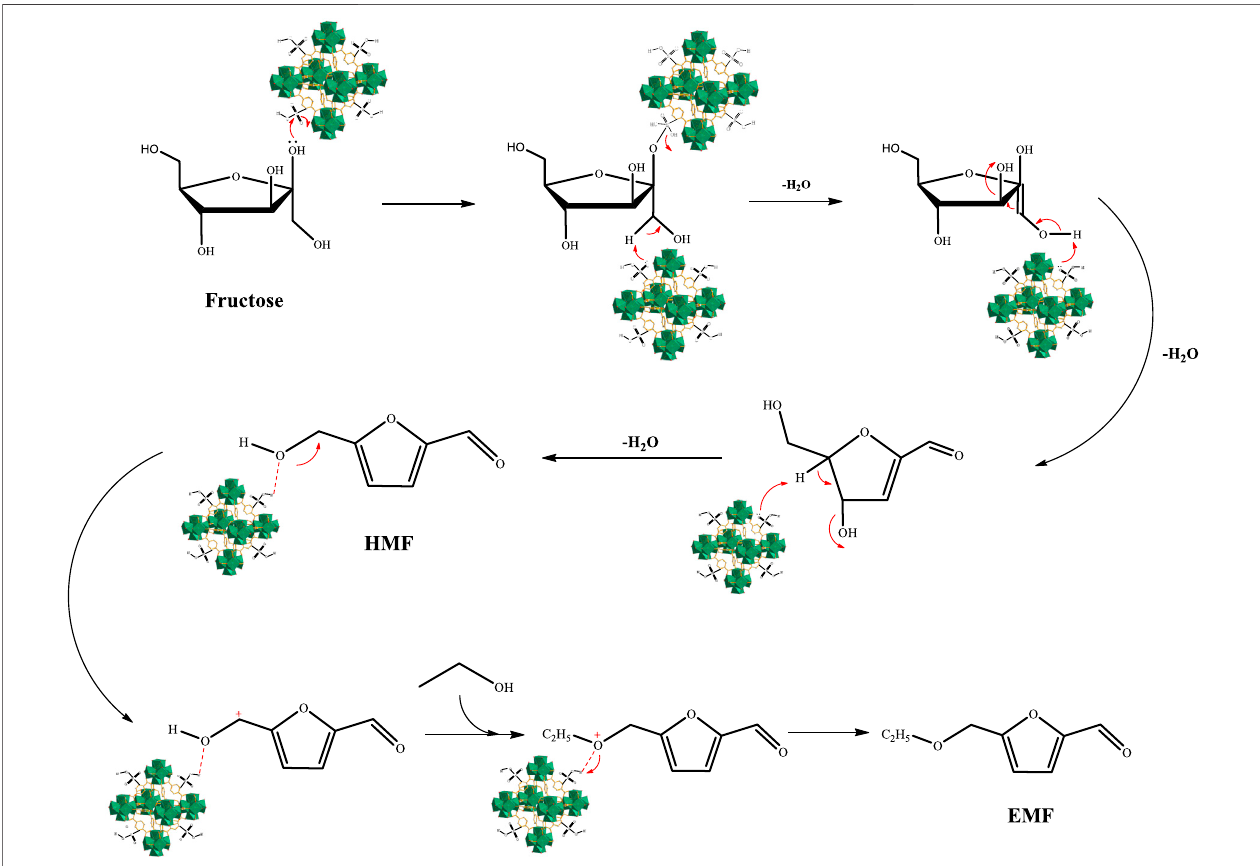
FIGURE 10 | Possible reaction mechanism for the conversion of fructose to EMF in ethanol catalyzed by UIO-66-SO 3 H(Amarasekara et al., 2008; Ohara et al., 2010; Yan et al., 2022).